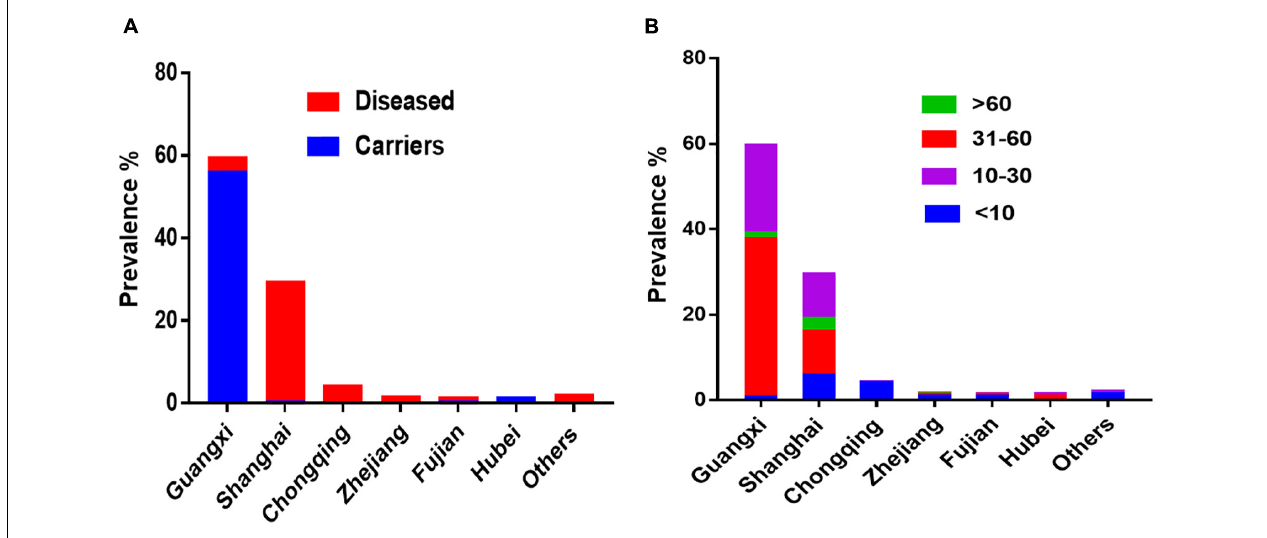
FIGURE 4 | The prevalence of S . Rissen human isolates in China. (A) Prevalence of S. Rissen isolates from clinics and asymptomatic carriers in different provinces or province-level cities in China. (B) Prevalence of S . Rissen isolates from different age-group of humans recovered from different provinces or province-level cities in China. This suggests that the most prevalent age-group was the children under the age of